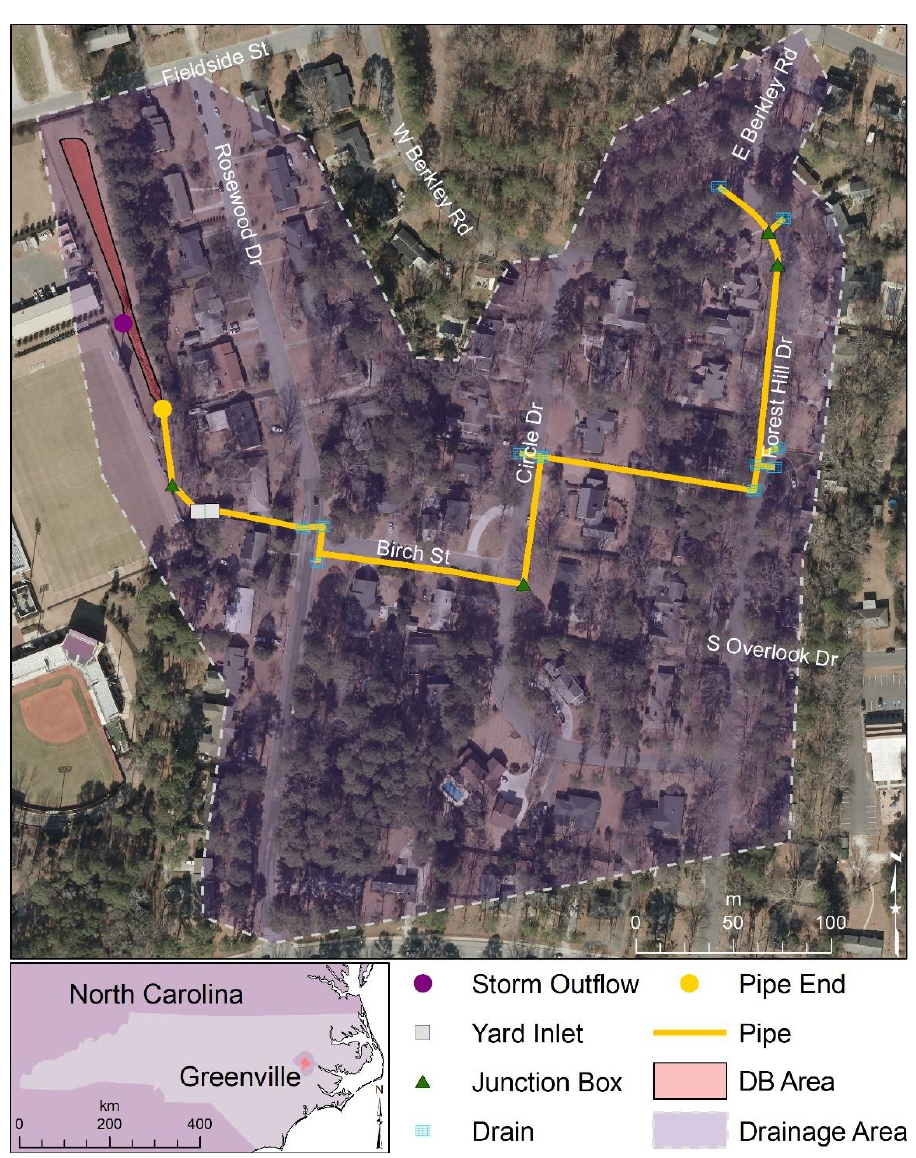
Figure 1. A dry detention basin (DB) with wetland characteristics receives drainage from a 15.7 ha watershed in Greenville, NC, USA.